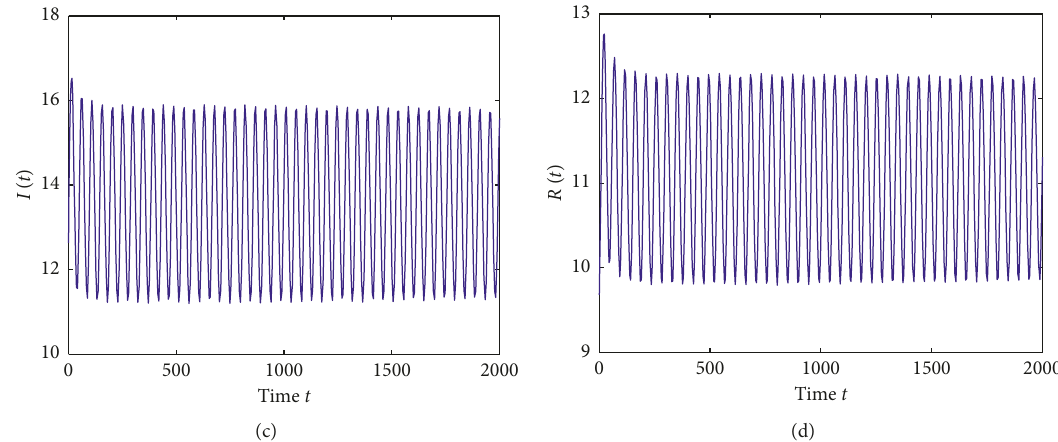
Figure 3: Waveform plots of system (65) with τ